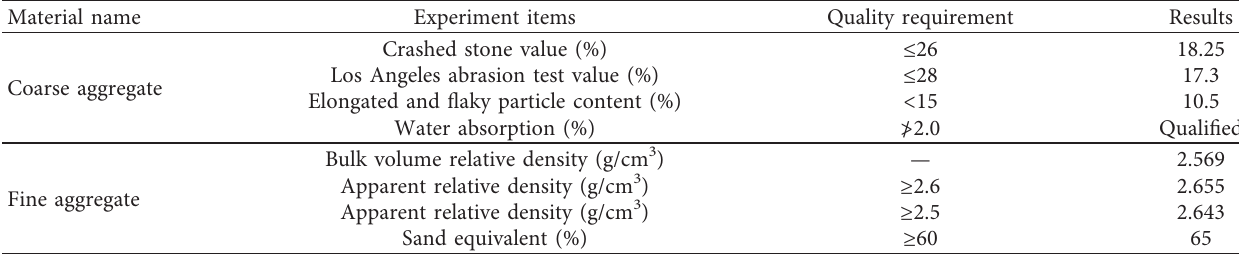
Table 1: The performance of coarse aggregate.